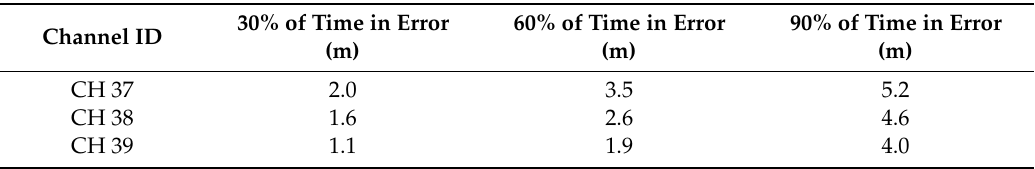
Table 1. Distance errors in CH 37, CH 38 and CH 39.